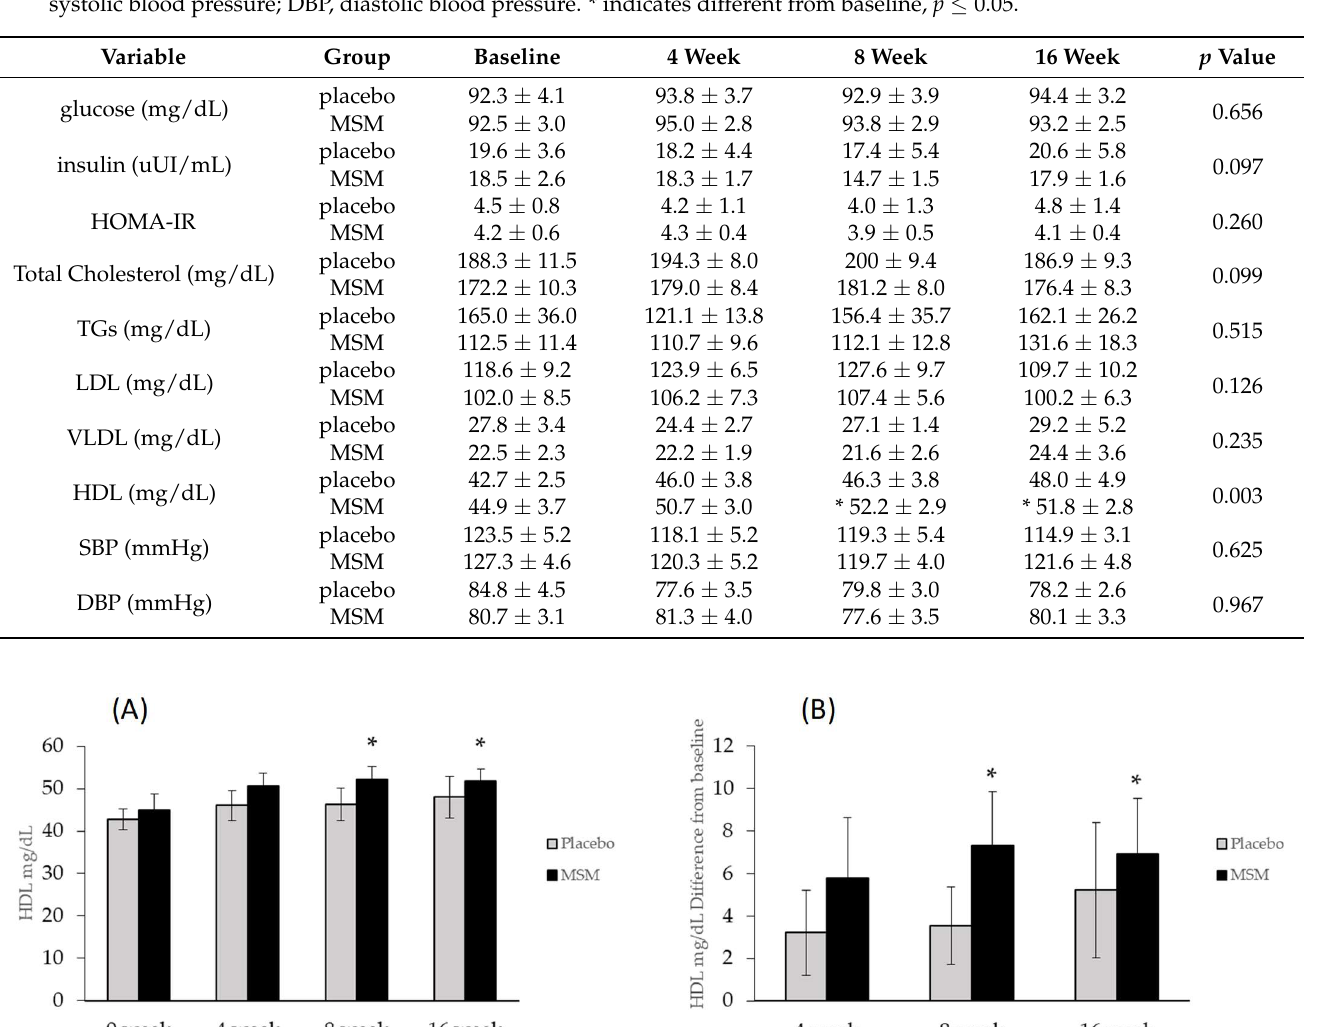
Table 3. Markers of inflammation, oxidative status, and cardiac fibrosis. All measures expressed relative to total serum protein content. TAC, Total antioxidant capacity; TNF-α, Tumor necrosis factor-α, IL-6, Interleukin-6; 4-HNE, Trans-4- Hydroxy-2-nonenal; PINP, Procollagen I N-terminal peptide; PIIINP, procollagen III N-terminal peptide. Variable